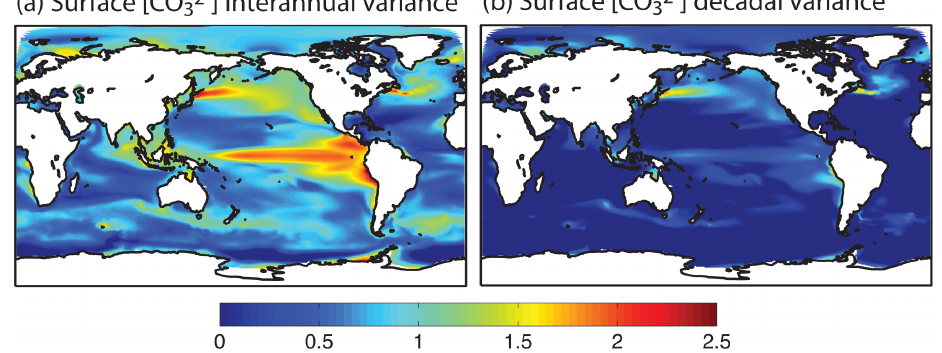
Figure 3. Blue bars: probability density of interannual standard deviation of simulated [CO 2 − periods and (b) HOT, based on 36 independent 25-year periods. Black line: interannual standard deviation of surface [CO 2 − and (b) HOT, based on detrended annual-mean observations.